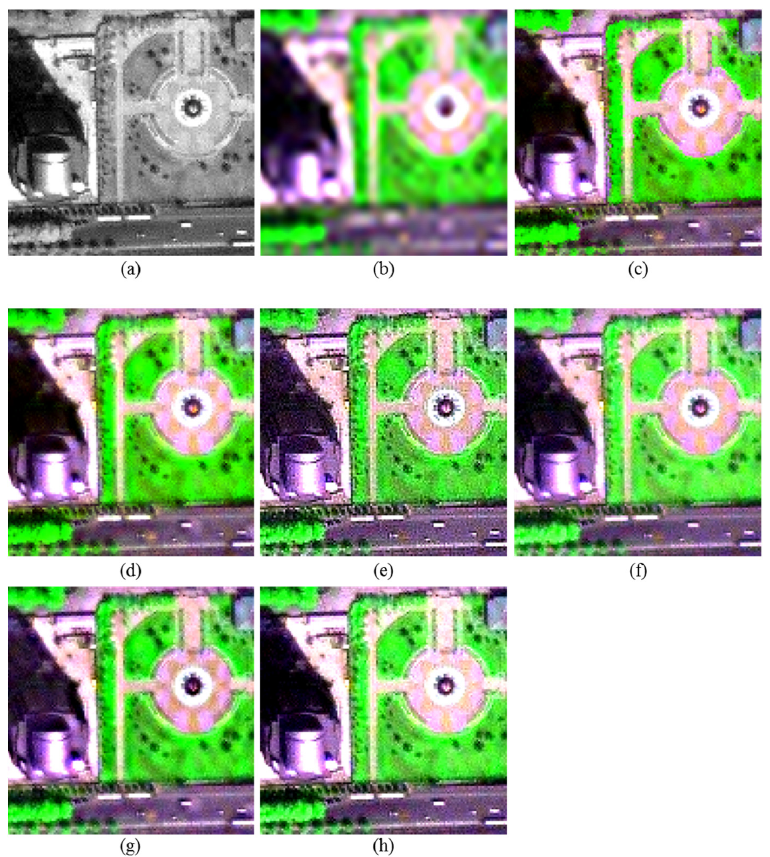
Figure 9. The 128 × 128 subsets of the MS and PAN images and the corresponding fused images produced from the original IKONOS dataset: ( a ) 1-m PAN image; ( b ) up-sampled version of the 4-m MS image; and the results of ( c ) UHR fusion; ( d ) HR fusion; ( e ) PS fusion; ( f ) GS1 fusion; ( g ) GS2 fusion and ( h ) GSA fusion.